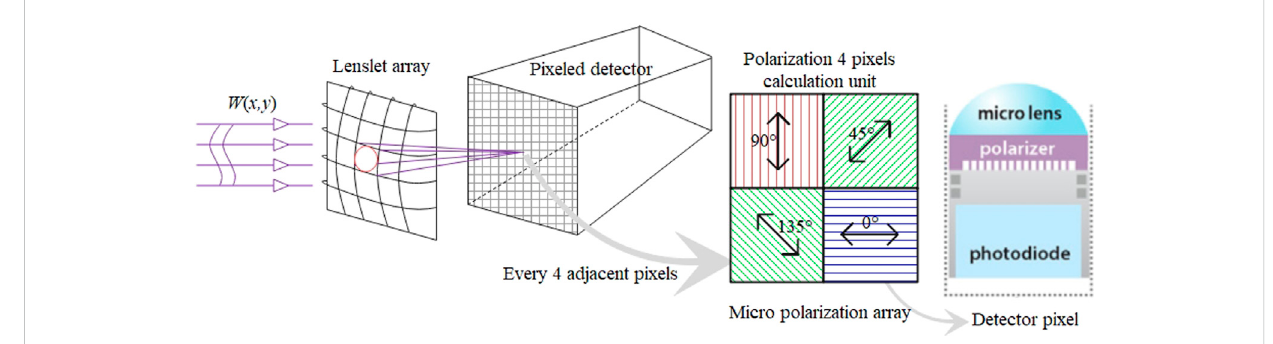
FIGURE 1 P-SHWFS structure and polarization dimension calculation unit [18].